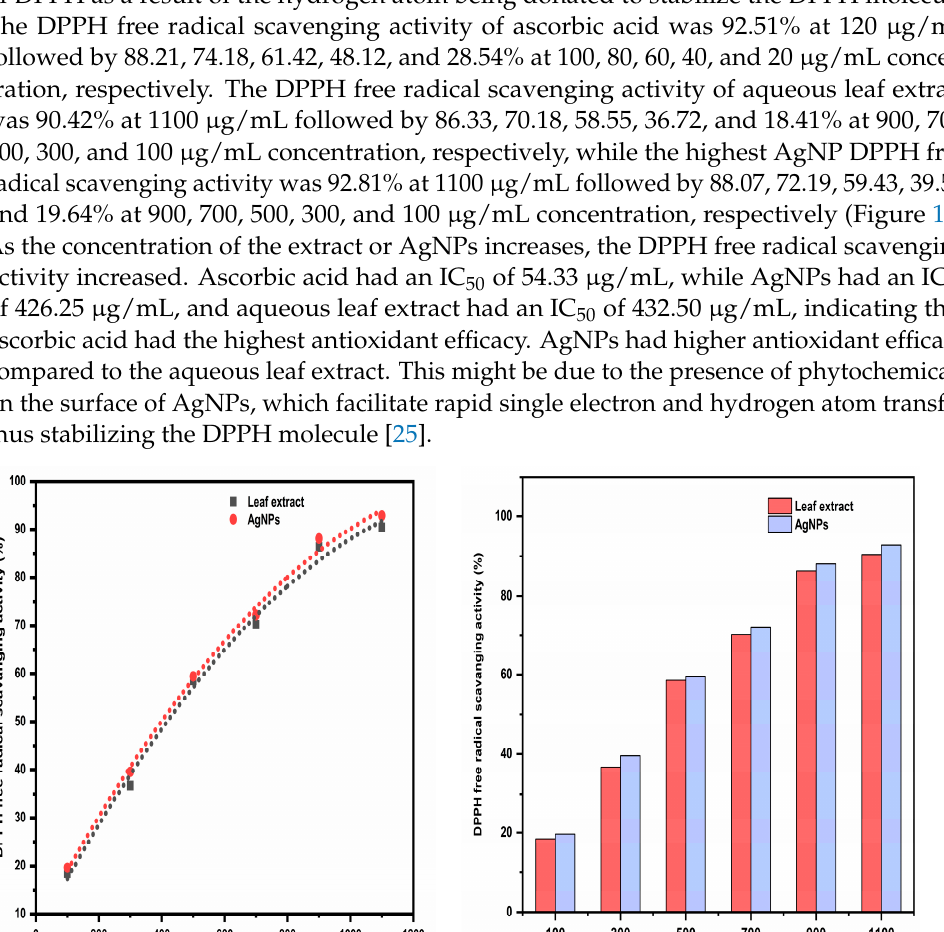
The total antioxidant capacity of the aqueous leaf extract and the biosynthesized AgNPs was estimated with the help of a standard curve using ascorbic acid. The anti ‐ oxidants present in the sample had the ability to reduce molybdenum (VI) to a green colored phosphomolybdate (V) complex. The AgNPs (64.36 mg AAE/g) demonstrated greater antioxidant capacity compared to the aqueous leaf extract (55.61 mg AAE/g) at a concentration of 1100 μ g/mL (Figure 14). The attachment of phenolics and flavonoids on the surface of AgNPs might be the cause of its improved antioxidant activity. Figure 14. Comparative total antioxidant capacity of aqueous leaf extract and the biosynthesized AgNPs.